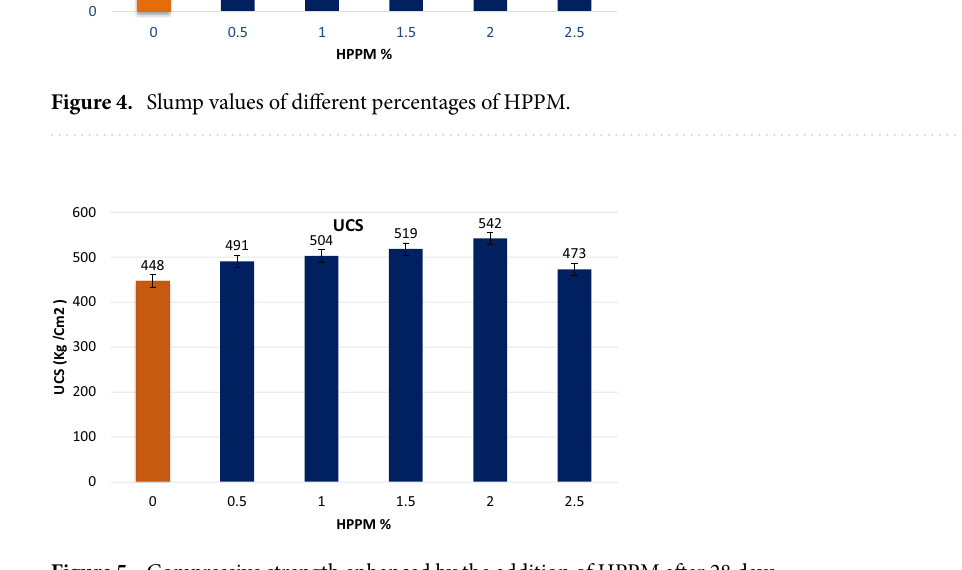
Figure 5. Compressive strength enhanced by the addition of HPPM after 28